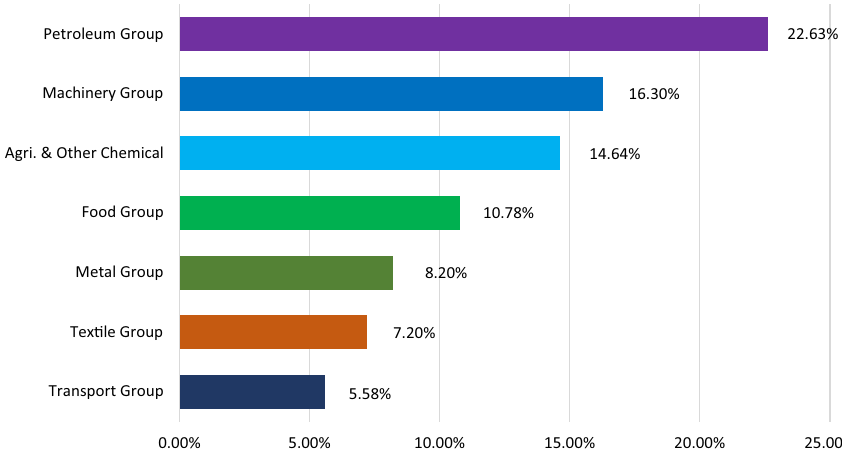
Fig. 2 Sector-wise imports of Pakistan in 2017. Source: State Bank of Pakistan